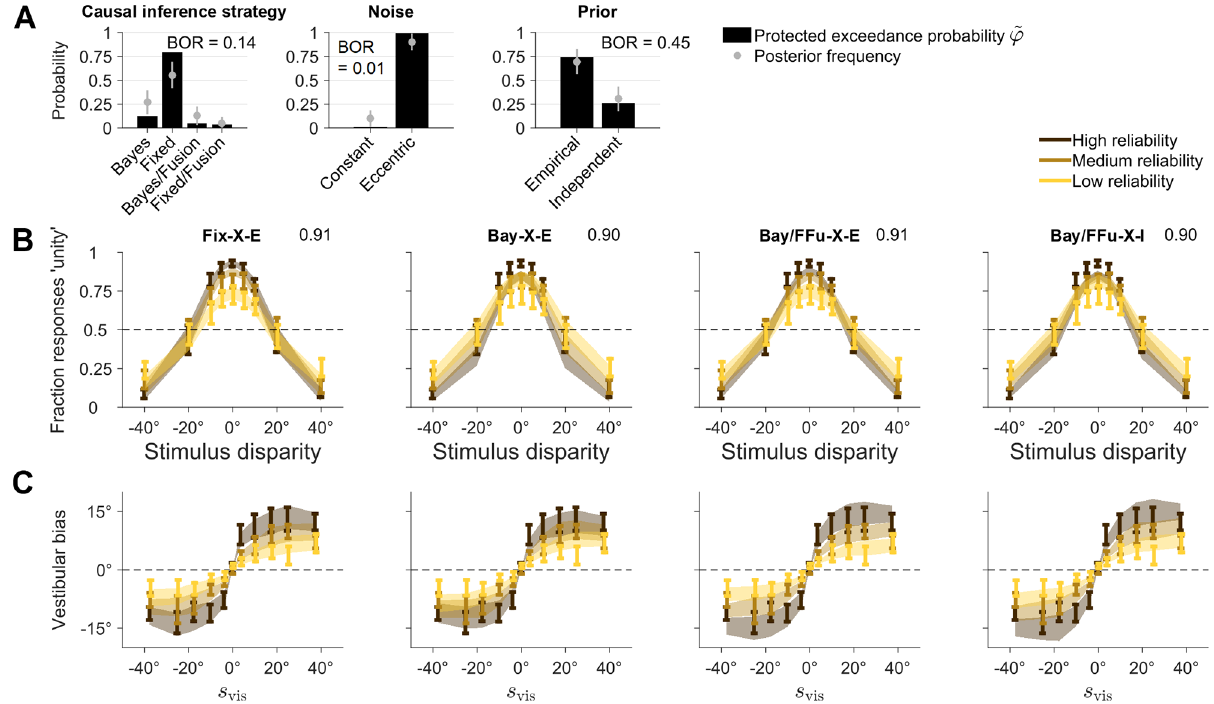
Fig 6. Joint fits. Results of the joint fits across tasks. A : Protected exceedance probability ~ φ and estimated posterior frequency (mean ± SD) of distinct model components for each model factor. Each factor also displays the Bayesian omnibus risk (BOR). B : Joint model fits of the explicit causal inference (unity judgment) task, for different models of interest. Each panel shows the proportion of ‘unity’ responses, as a function of stimulus disparity and for different levels of visual reliability. Bars are ± 1 SEM of data across subjects. Shaded areas are ± 1 SEM of model predictions across subjects. Numbers on top right of each panel report the absolute goodness of fit across all tasks. C : Joint model fits of the implicit causal inference task, for the same models of panel B. Panels show vestibular bias as a function of co-presented visual heading direction s vis , and for different levels of visual reliability. Bars are ± 1 SEM of data across subjects. Shaded areas are ± 1 SEM of model predictions across subjects.